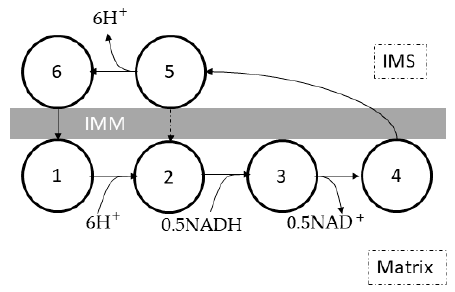
Figure 3. Schematic of the lumped complex I-III-IV model by Magnus and Keizer [54]. The six-state proton pump consists of proton translocation (5 → 6 → 1 → 2), NADH oxidation (2 → 3 → 4), and a slip reaction (5 → 2). Each cycle represents one electron transfer from NADH to oxygen, coupled with the translocation of 6 protons from the matrix to the intermembrane space (IMS). The arrows represent the forward reaction direction, although all reactions are reversible. Reprinted/adapted with permission from Ref. [54].